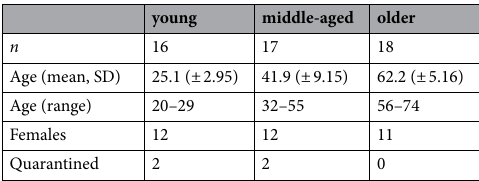
Table 1. Sample characteristics in age groups.